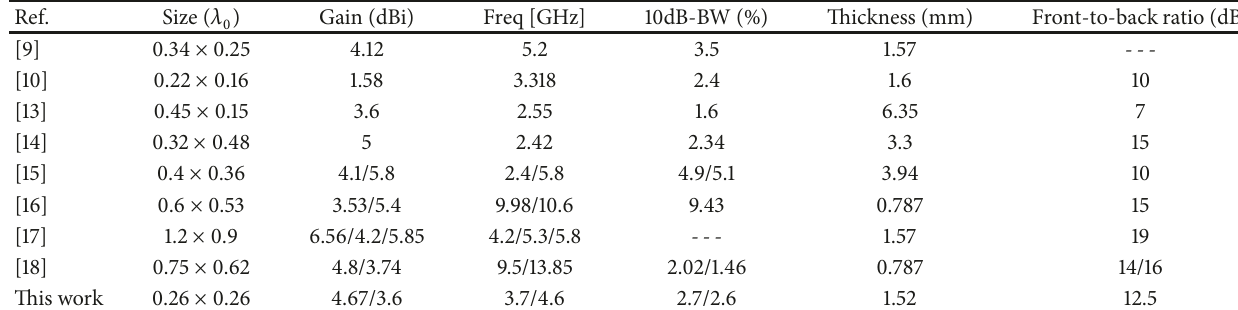
Table 3: Comparison with the reported back-cavity